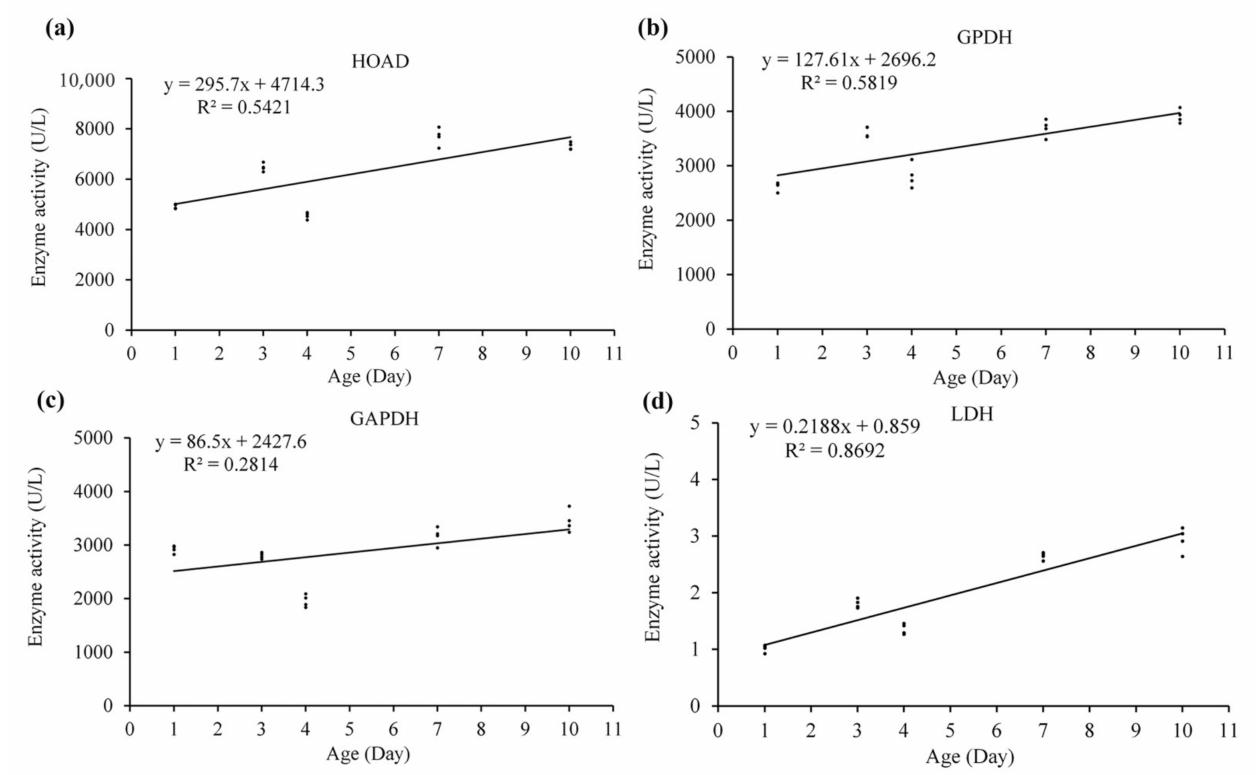
Figure 12. Linear regression between enzyme activity and age in S. frugiperda females. ( a – d ) are linear regression of HOAD, GPDH, GAPDH and LDH with age,